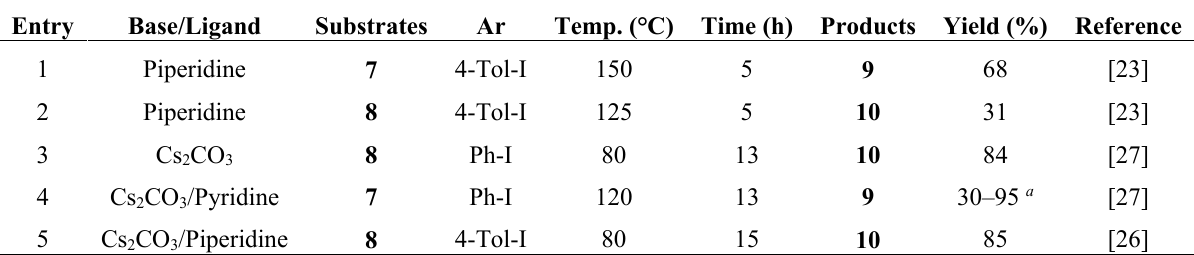
Table 1. Effect of different bases on Pd-catalyzed direct C8-H arylation of adenosine 7 and 2'-deoxyadenosine 8 with aryl